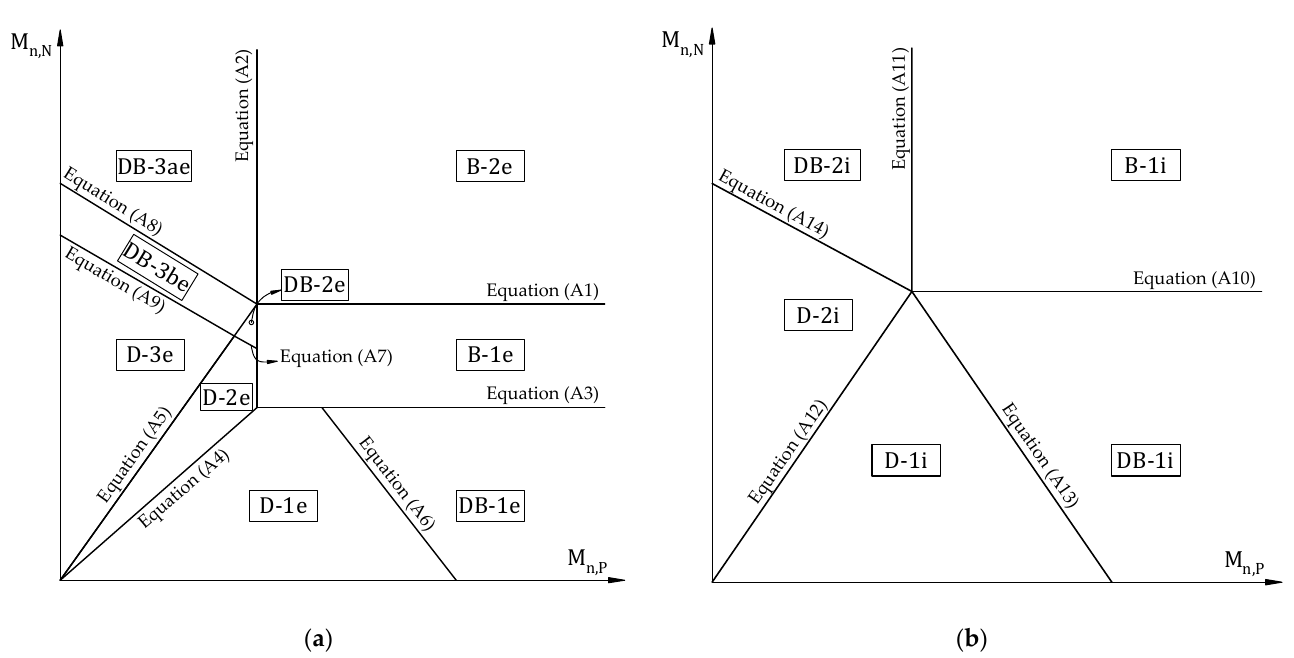
Figure 3. Different failure modes according to moment and shear capacities of continuous RC slabs for ( a ) end span and ( b ) interior span. Table 1. An overview of the different failure modes of continuous RC slabs.